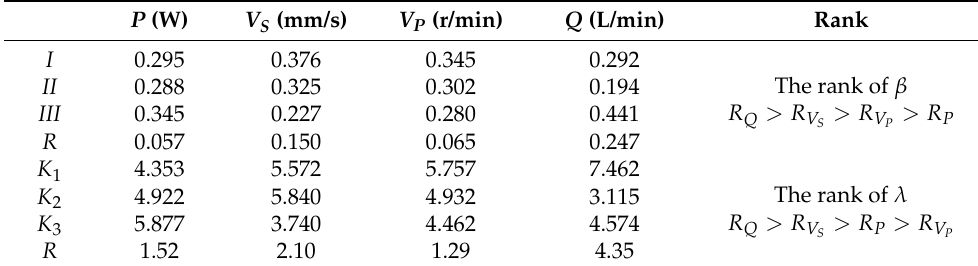
Figure 7. The interaction of the four parameters. 3.2. Effect of Lap Rate on Forming Stability 3.2.1. Effect of Overlap Rate on Forming Stability As shown in Figure 8, the overlap rate ( δ ) decreases as D increases. When D is 0.6 mm and 0.8 mm, the overlap joint of each coating layer is extremely obvious with the stacking phenomenon and forms the inclined surface. This phenomenon is the opposite direction of the sequence of cladding. There is an overlap gap between the channels in- stead of the inclined surface when the center distance is 1.2 mm and 1.4 mm. Overlap is